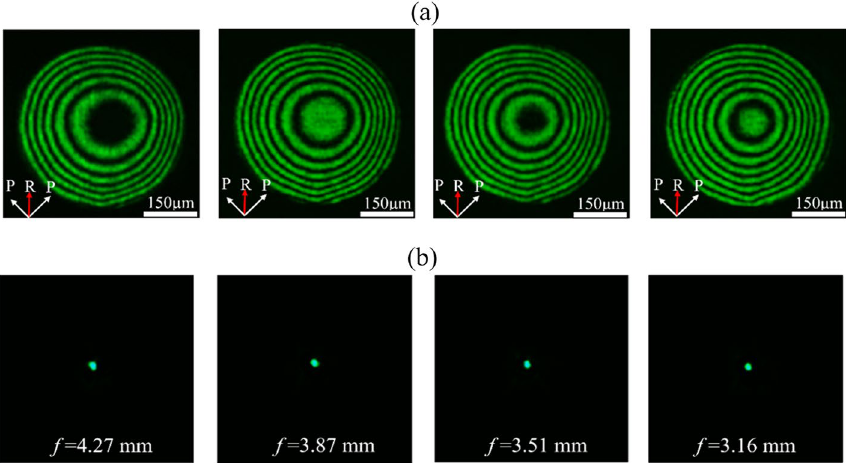
Figure 3. ( a ) The optical system for measuring interference patterns with applied frequency signals of 130 kHz at different working voltages of 1.8, 2.0, 2.2 and 2.4 V rms , respectively and the corresponding focusing beam spots ( b